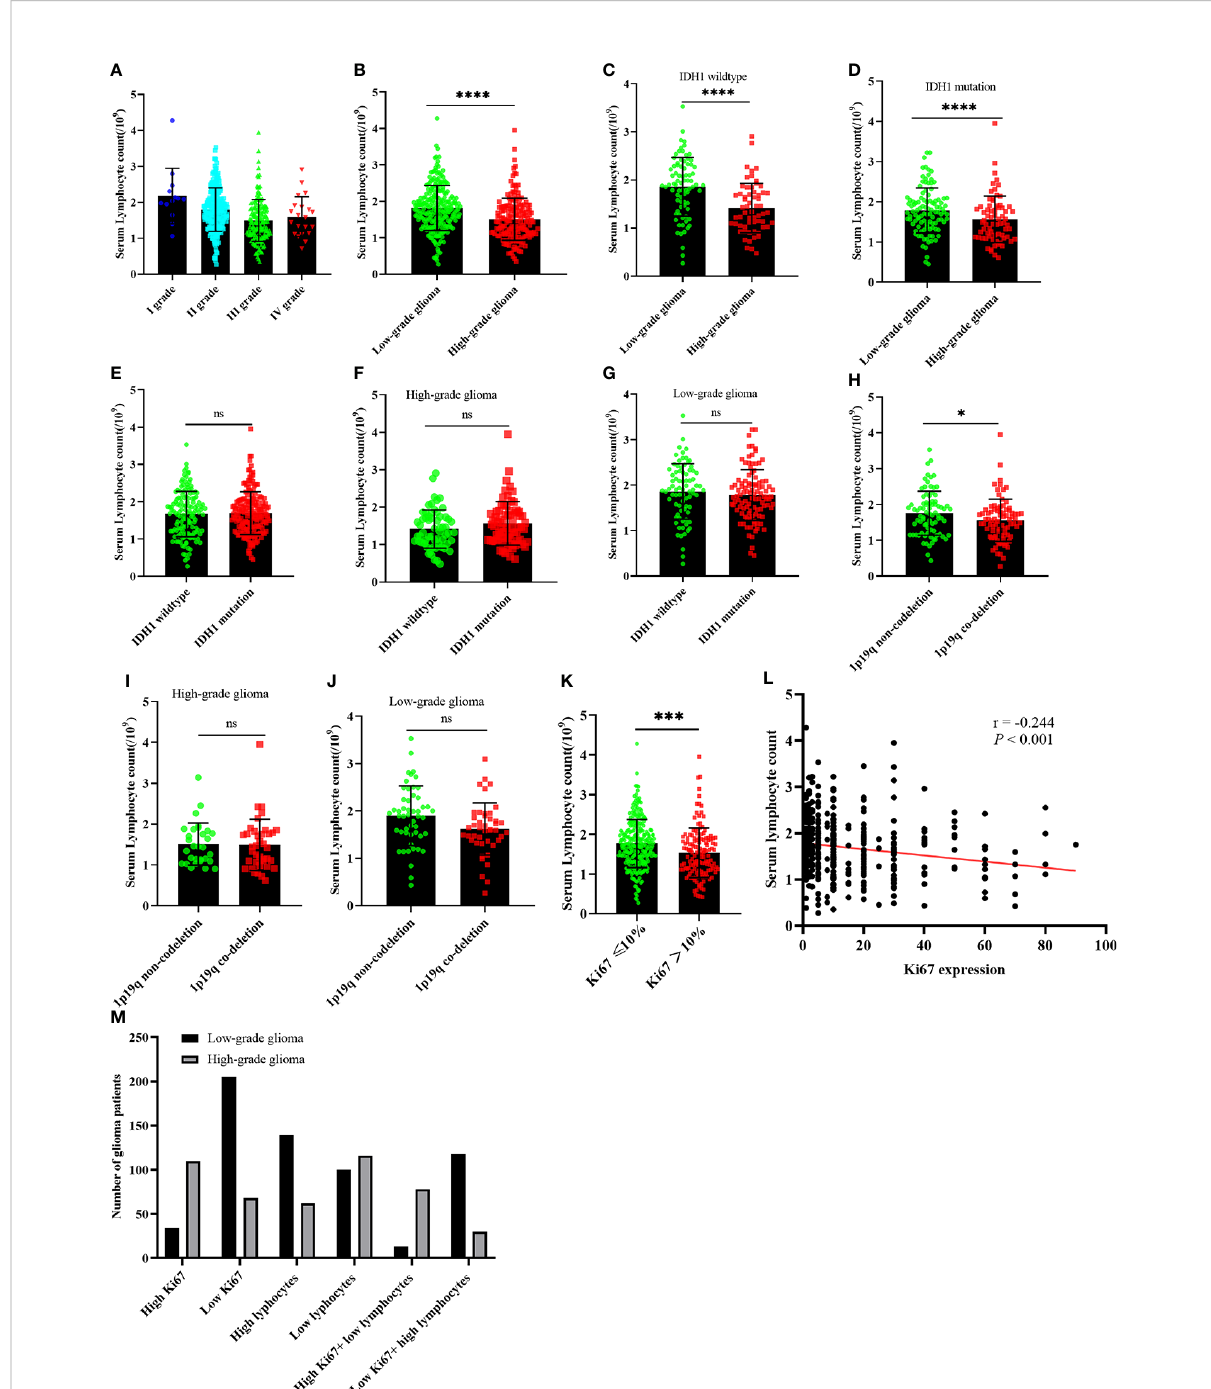
FIGURE 3 The relationship between serum lymphocyte count and glioma, IDH1 mutation status, 1p19q co-deletion status, and serum ALU correlation with glioma. (A, B) serum lymphocyte count in glioma; (C, D) serum lymphocyte count correlation with glioma in IDH1 mutation group and IDH1 wild-type group; (E – G) serum lymphocyte count correlation with IDH1 mutation status in all glioma, HGG, and LGG; (H – J) serum lymphocyte count correlation with 1p19q co-deletion status in all glioma, HGG, and LGG; (K) serum lymphocyte count correlation with Ki-67 expression in all glioma; (L) linear correlation between serum lymphocyte count and Ki-67 expression; (M) the number of patients with Ki-67 expression and serum lymphocytes count. LGG, lower-grade glioma; HGG, High-grade glioma; ALU, albumin. ns P > 0.05, * P < 0.05, *** P < 0.001, **** P < 0.0001, mean ± standard deviation,